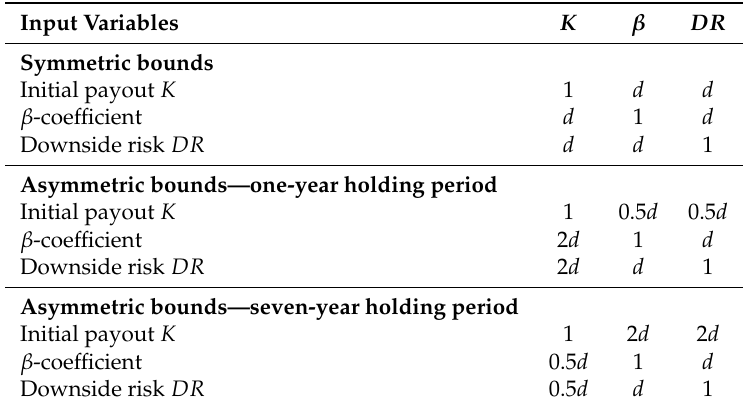
Table 10. Lower bounds considered for the assurance regions (AR) restrictions in the performance analysis of mutual funds for d ∈ [ 0,0.9 ] . The lower bounds are calculated dividing the values reported in the table by the ratio between the mean values of the